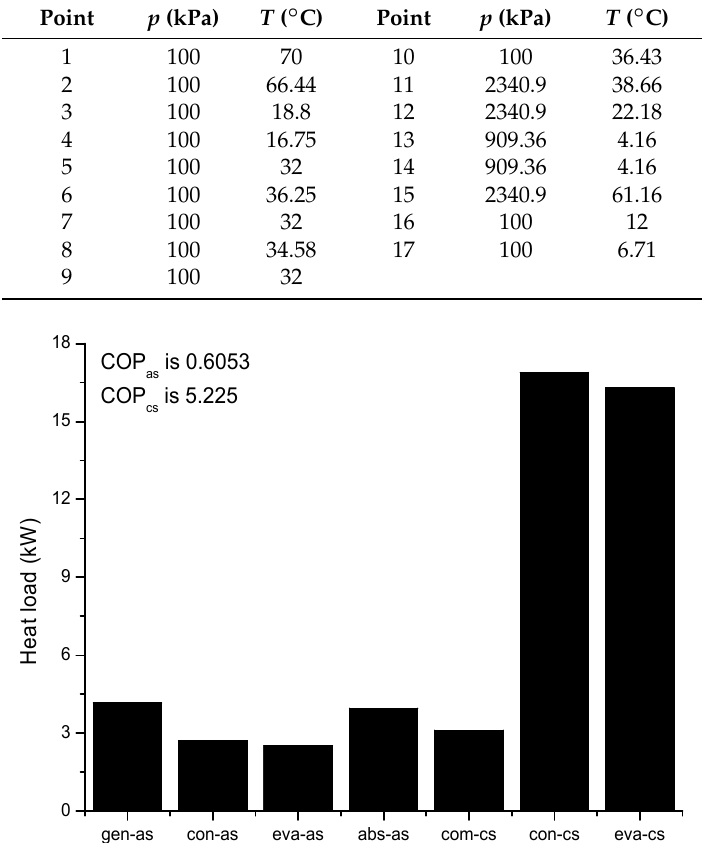
Figure 5. Performance of hybrid system in the design condition.